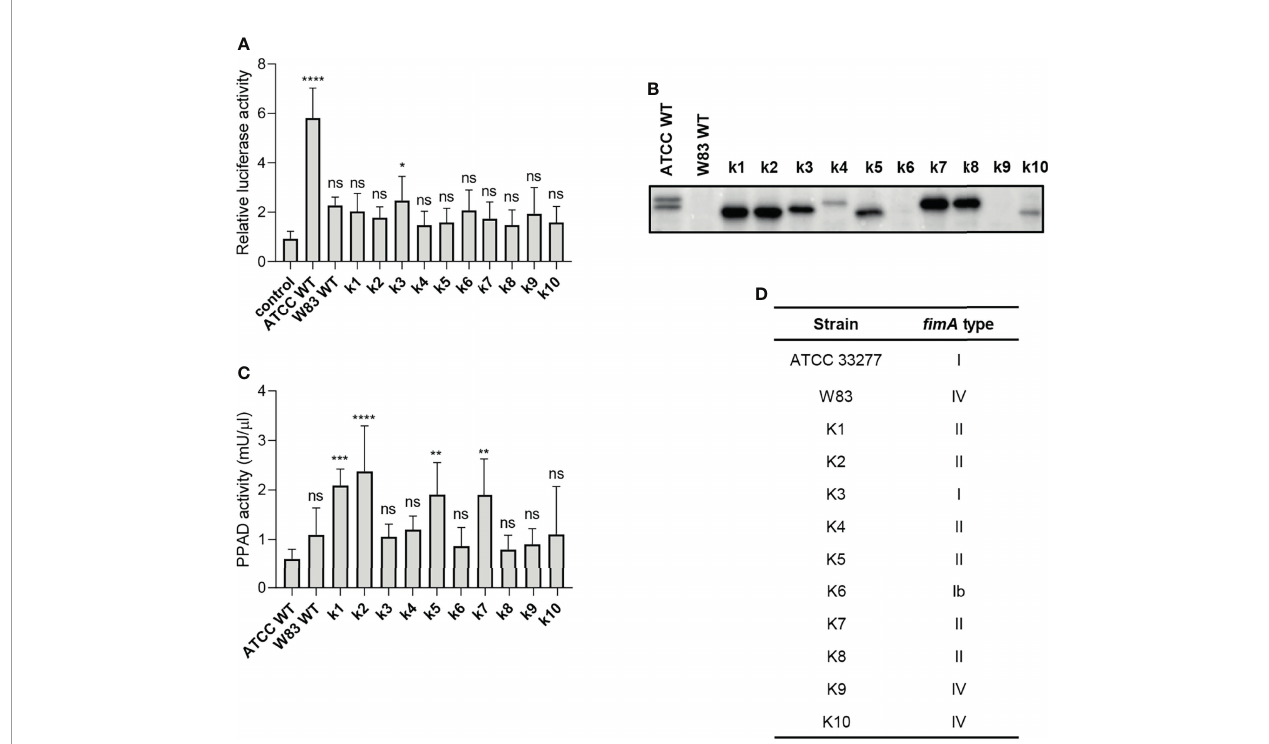
FIGURE 4 | The ability of clinical strains to activate TLR2 is much weaker than that of ATCC 33277. (A) Cells were infected for 4 h (MOI=100) with various clinical strains (k1-k10), ATCC 33277 (ATCC WT), or W83, n=4. Results are presented as the mean ± SD ratio of Fire fl y luciferase activity to b -galactosidase activity and are normalized to cells stimulated/infected with the same factor and transfected with an empty vector. (B) Western blot analysis of laboratory and clinical strain cultures (adjusted to OD 600 ) to detect FimA. (C) PPAD activity in whole laboratory and clinical strain cultures (adjusted to OD 600 ), n=6. Results were compared with those from the ATCC 332777 strain. *p < 0.05; **p < 0.01; ***p < 0.001; ****p < 0.0001; ns, no statistical signi fi cance. 1-way ANOVA followed by Tukey ’ s multiple comparisons test. (D) The FimA type determined by sequencing of the fi mA gene in clinical